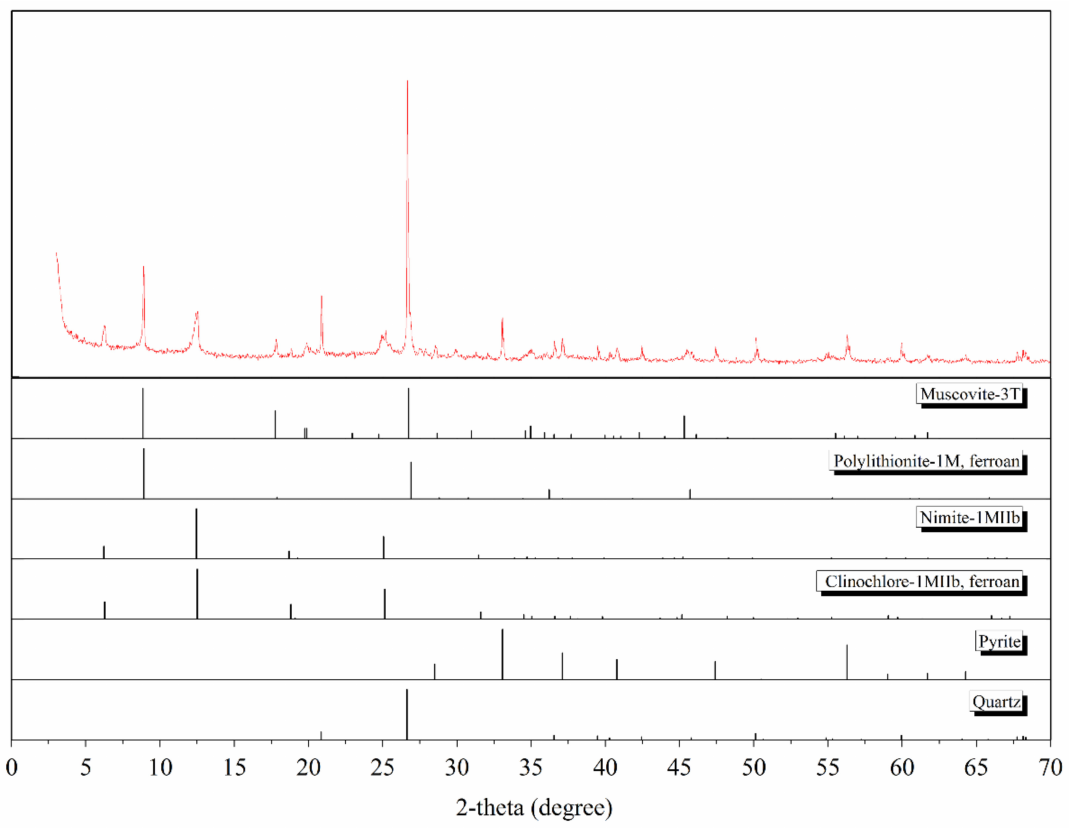
Figure 4. XRD result of the high-density fraction (>1.8 g/cm 3 ). The washability curves for >0.5 mm coal are given in Figure 5. The degrees of washa- bility of clean coal as a function of ash content and the corresponding values of fluorine, sulfur, and net calorific value in clean coal are presented in Table 3. The cumulative yield of clean coal is 72.97% when the ash content is 15%.